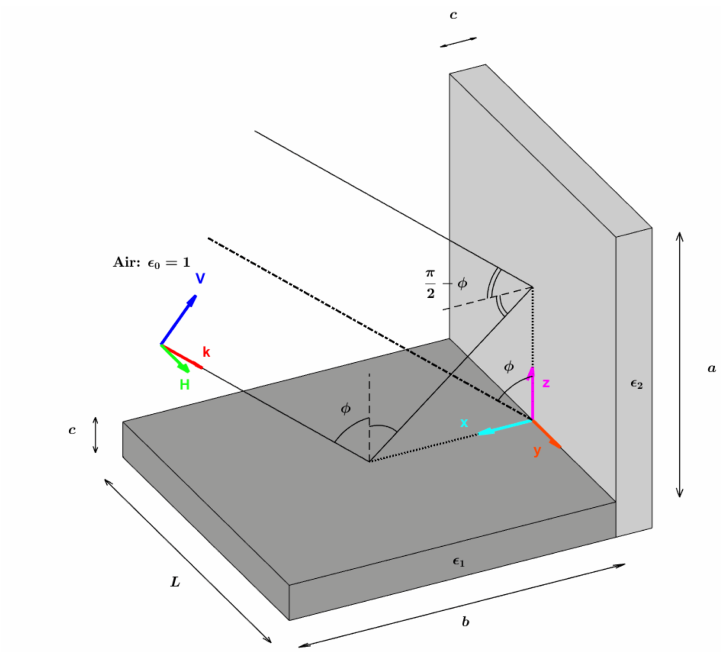
Figure 3. Illustration of a dielectric dihedral illuminated by an incident angle φ and with no orientation angle ( ψ =